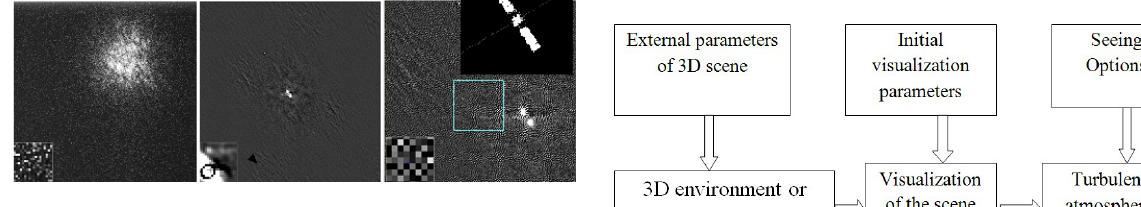
through bispectral processing and its 3D-model; the field of view – 4 arcsec).